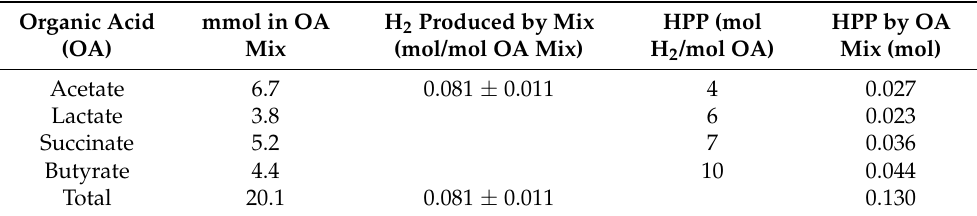
Table 1. H 2 generated in this study compared to HPP of the OA mix. STDEV with n = 3 (number of